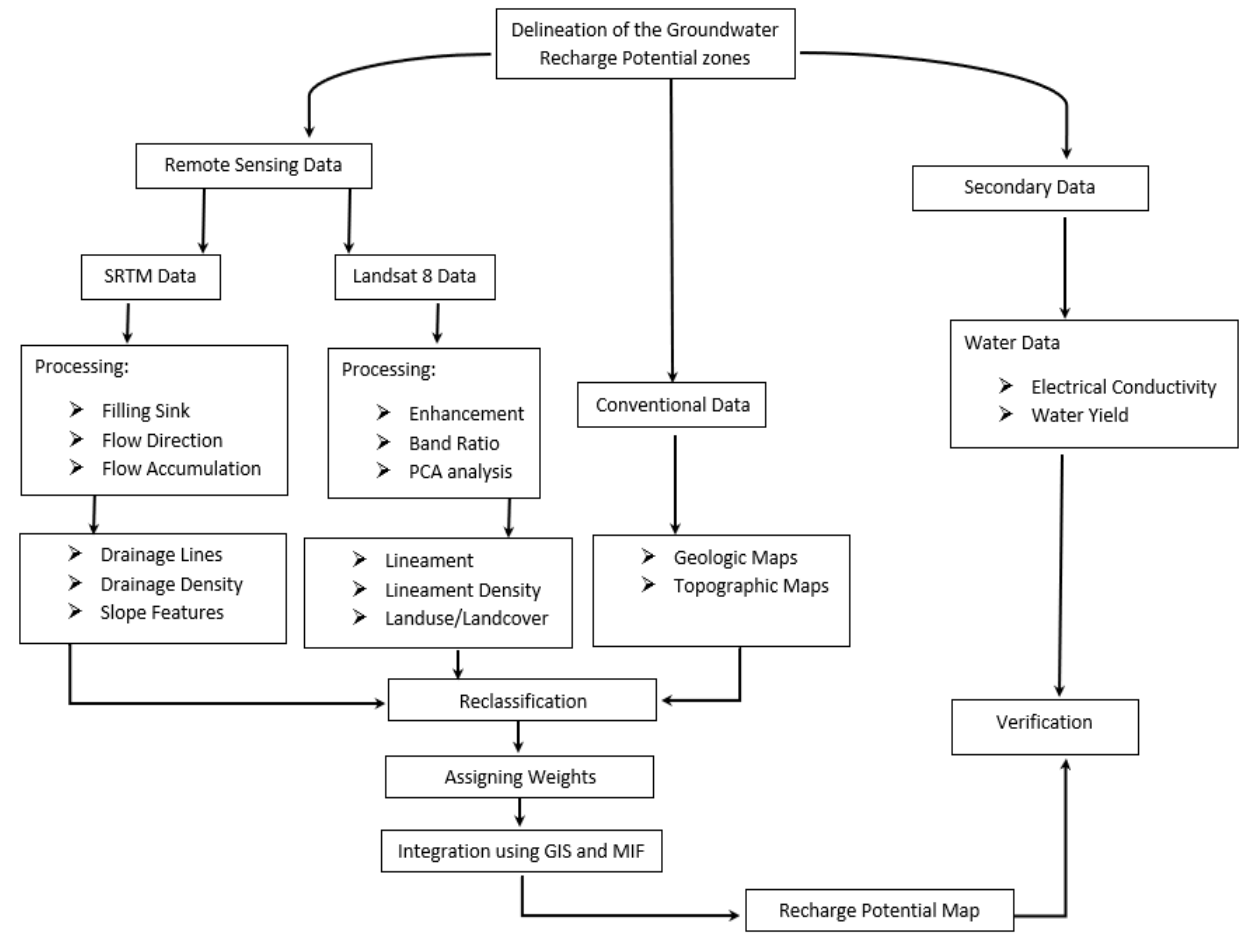
Figure 4. Materials and methods flowchart.